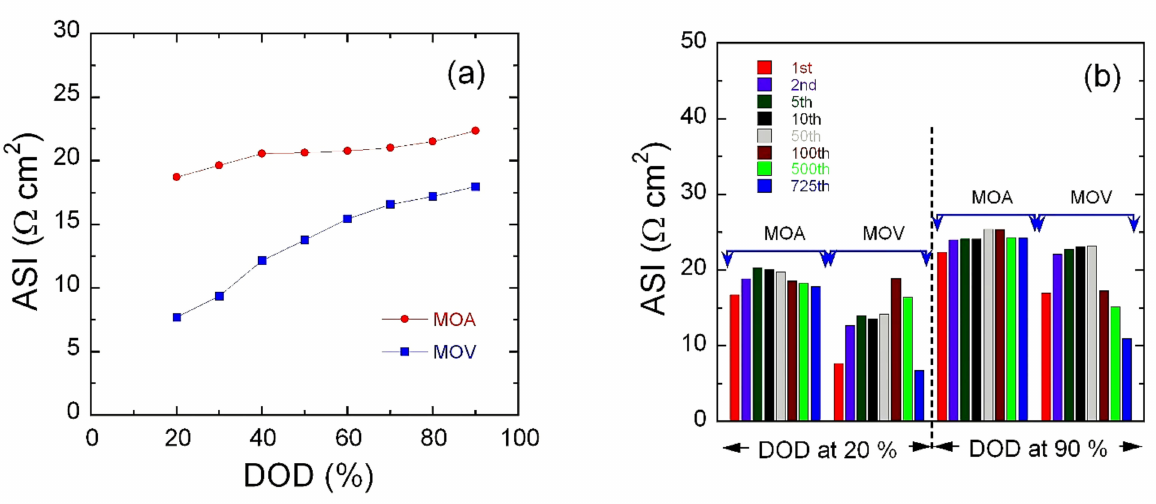
Figure 10. Area specific impedance (ASI) of the MOA and MOV as a function of depth of discharge (DOD) for the 1st discharge ( a ) and as a function of cycling for the MOA and MOV electrodes at 20% and 90% DOD ( b